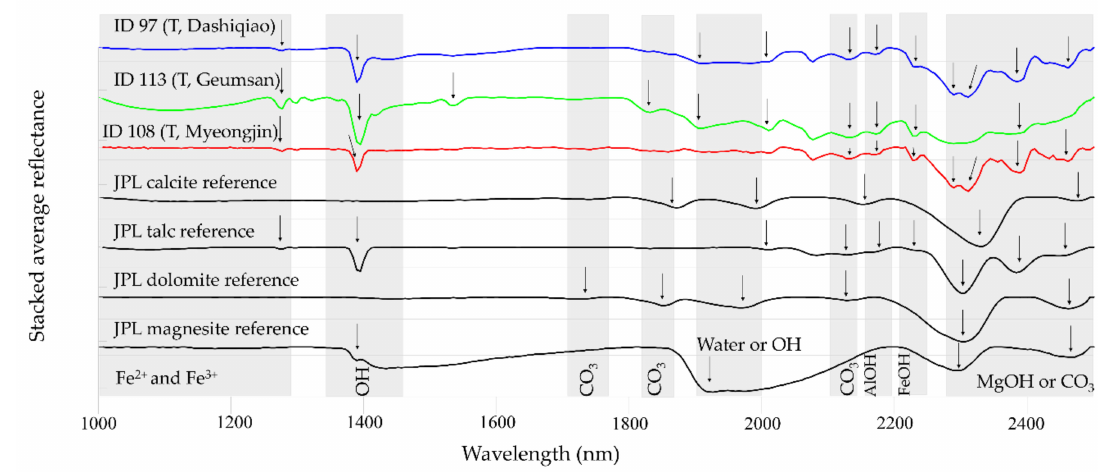
Figure 4. The average hull quotient corrected reflectance spectra of 3 groups of Talc sample pixels (red = group 1; green = group 2; blue = group 3) compared with the library reference